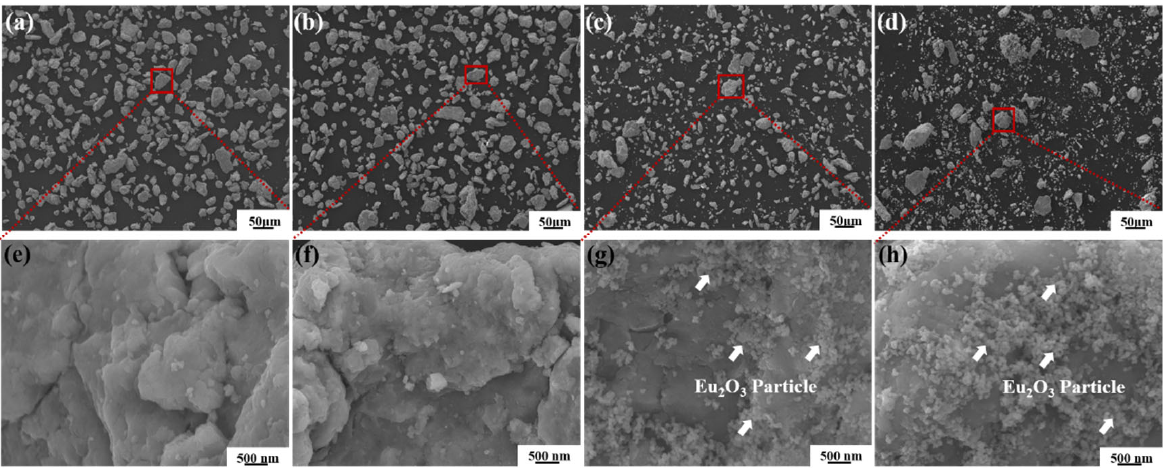
Figure 2. SEM images of the as ‐ milled powders with different Eu 2 O 3 mass percentages: ( a , e ) HP5; ( b , f ) HP10; ( c , g ) HP15; ( d , h ) HP20.